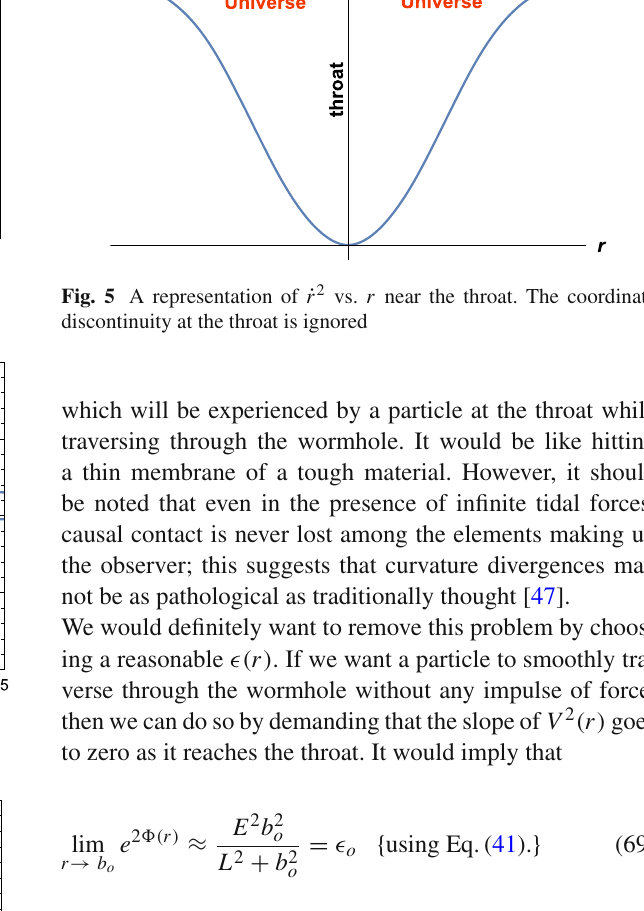
should almost vanish for it to not deviate much from its rigid structure. Pictorially, it is just the absolute difference between the slopes at the two points on V 2 ( r ) vs. r curve in Fig. 4. It can also be noted that without considering the significance of (cid:14)( r ) , we get a discontinuity in the slopes of the potential at the throat. That would correspond to an impulse of force